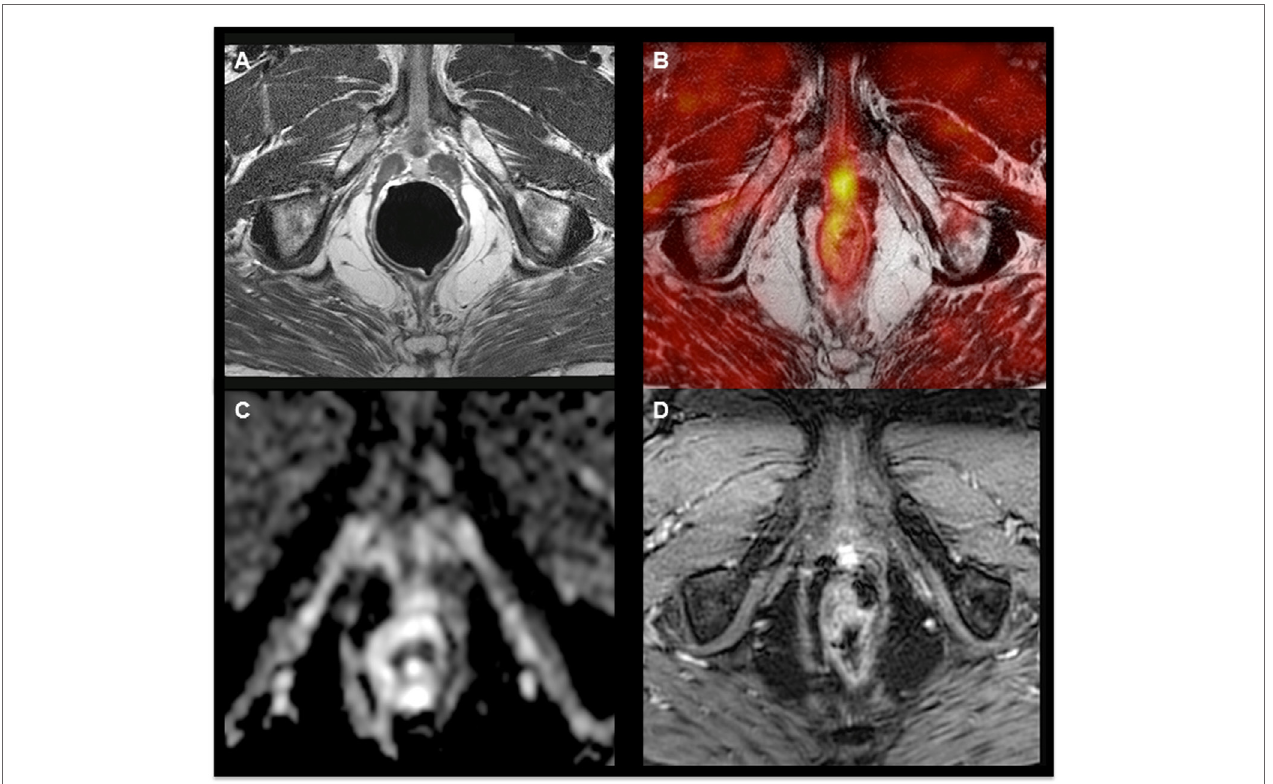
FiGURe 1 | 18 F-Fluorocholine hybrid PeT–MRi images showing hyperintensity on the T2-weighted sequence (A) and focal hypermetabolism (B) in a nodule with limited diffusion restriction on ADC map (C) and hyperperfusion (D) in a patient with a biochemical relapse (PSA = 1.75 ng/mL, doubling time = 11 months) 9 years after radical prostatectomy